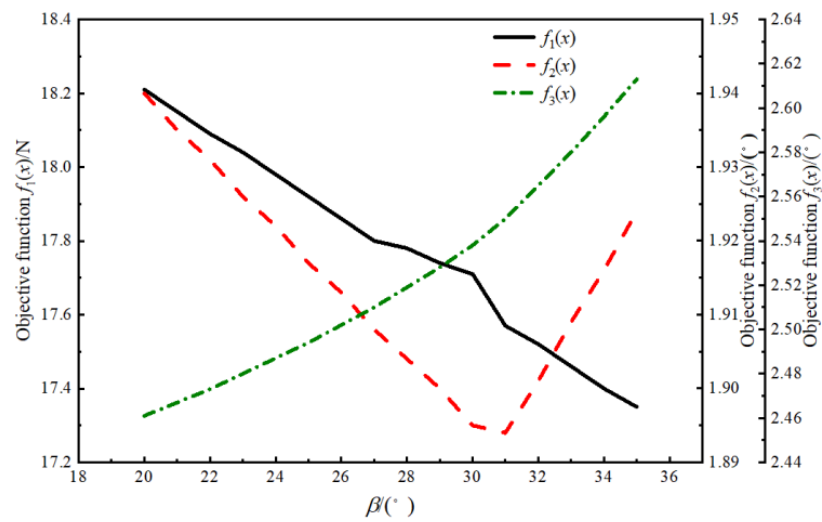
Figure 9. Variation curve of the objective function with the central angle β corresponding to the short side of the universal joint.